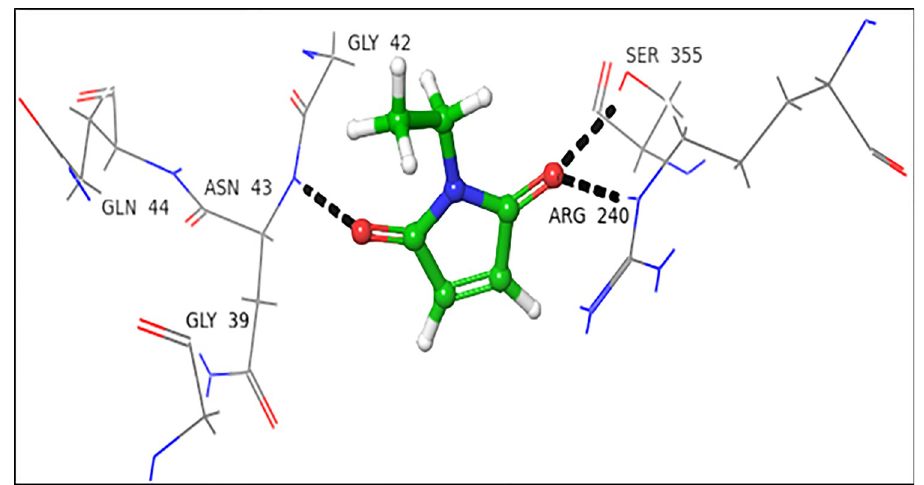
Fig 3. Interactions of NEM with donor active site 3ZY5. 3D Ligand interactions diagram: Black dashed lines represent hydrogen bonding.